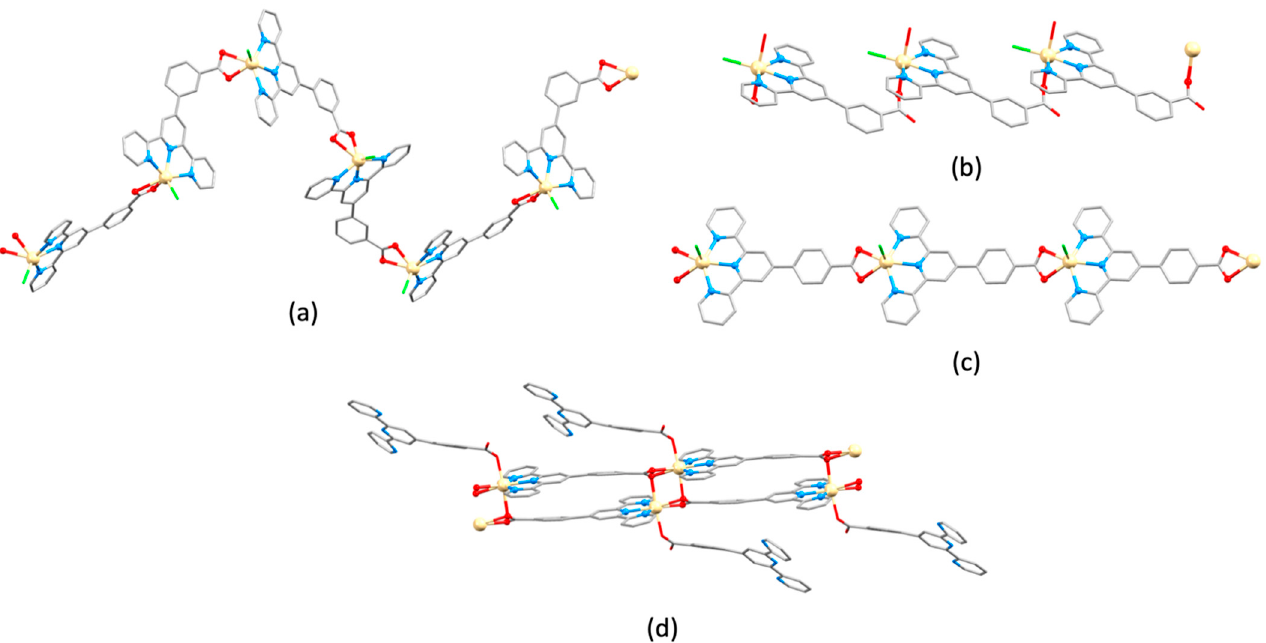
Figure 9. Part of a 1D-chain in ( a ) [Cd 2 ( 7 ) 2 Cl 2 ] n · n H 2 O (recode OBOFET), ( b ) [Cd( 7 )Cl(H 2 O)] n · n [Cd(H 7 )Cl 2 ] · n H 2 O (refcode OBIFIX), ( c ) [Cd( 4 )Cl(H 2 O)] n · 3.75 n H 2 O (refcode ZUDPAR), and ( d ) [Cd( 4 ) 2 ] n · n H 2 O (refcode KABTOY).